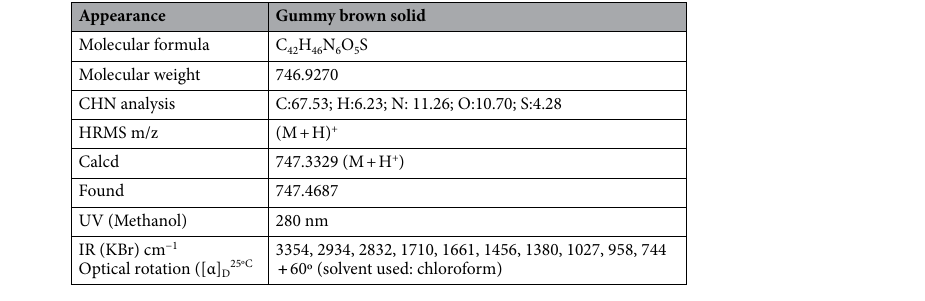
Table 1. Physicochemical properties of